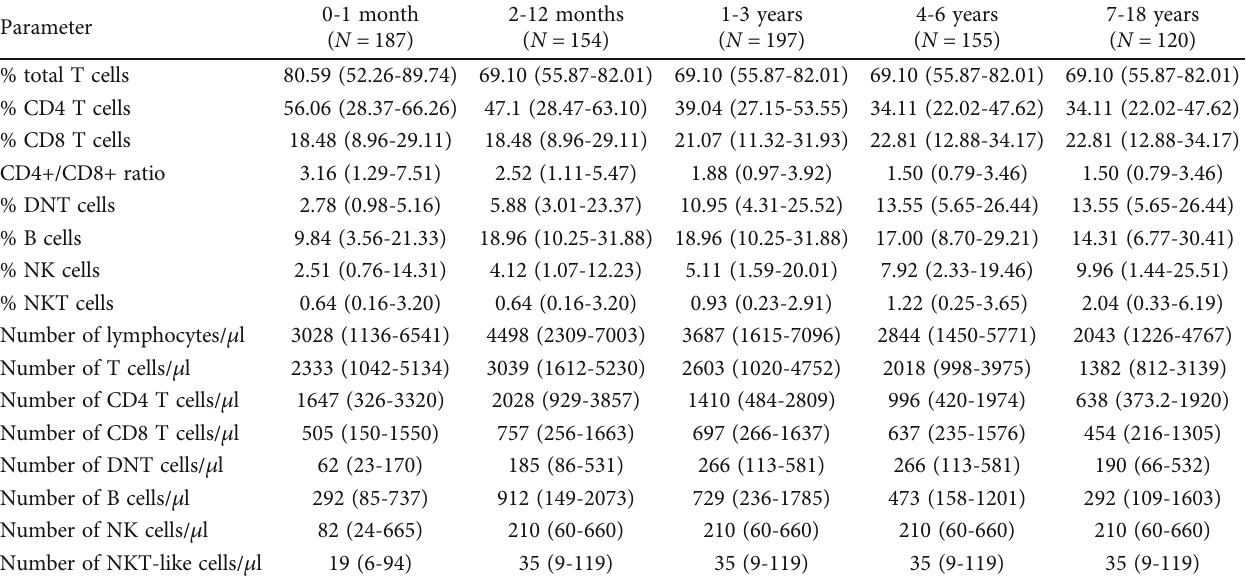
Table 3. The median, 2.5% and 97.5% distribution reference